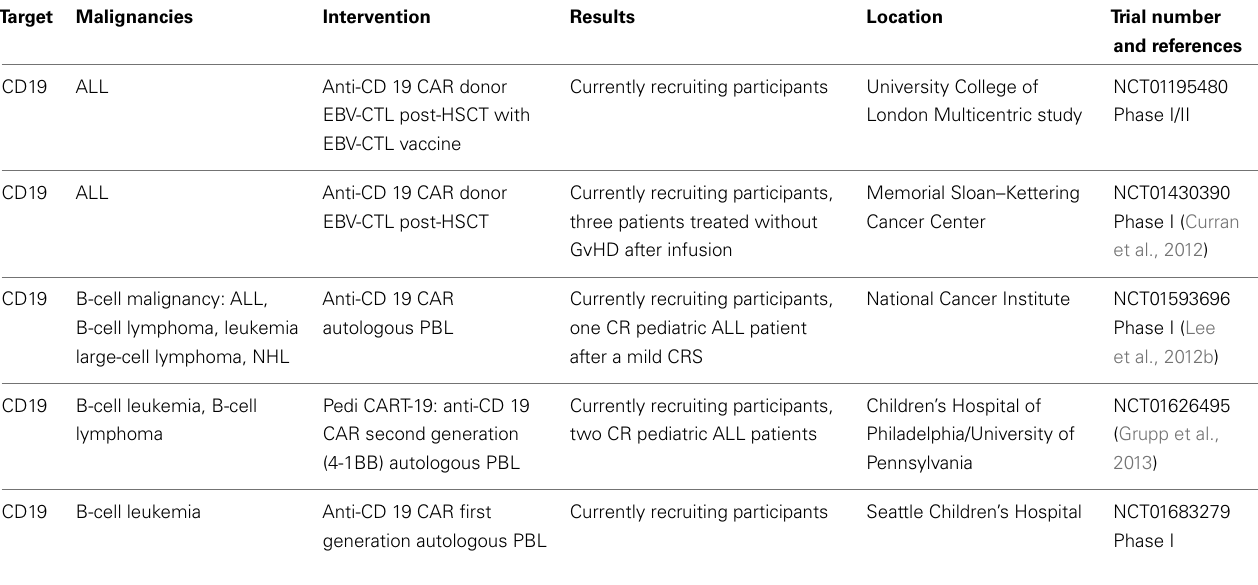
Table 2 | Ongoing pediatric clinical trials using